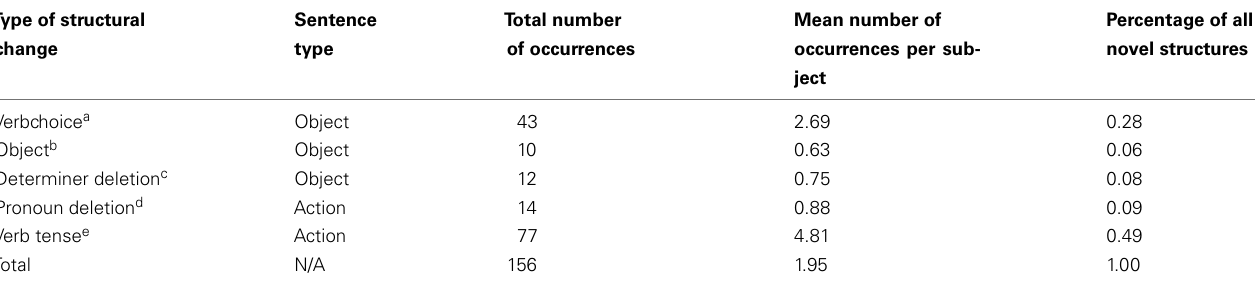
Table 1 | Departures from primed sentence